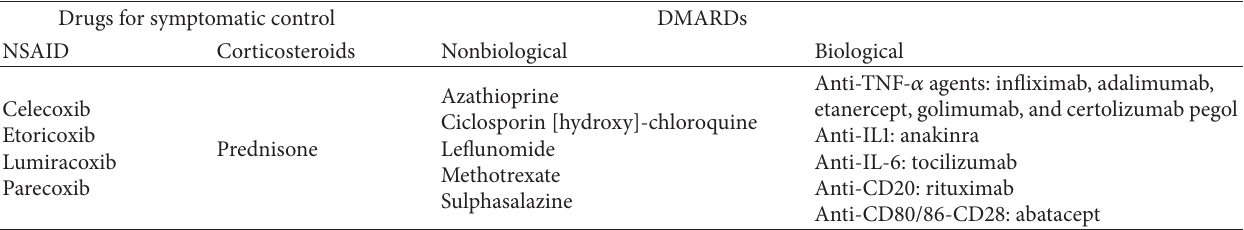
Table 1: Drugs used in the management of rheumatoid arthritis.